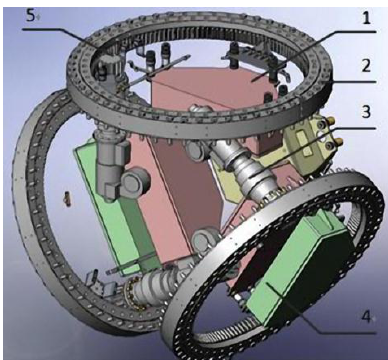
Figure 1. The structure of a pitch system [16]. (1) Pitch controller. (2) Slewing bearing. (3) Pitch motor. (4) Battery cabinet. (5)